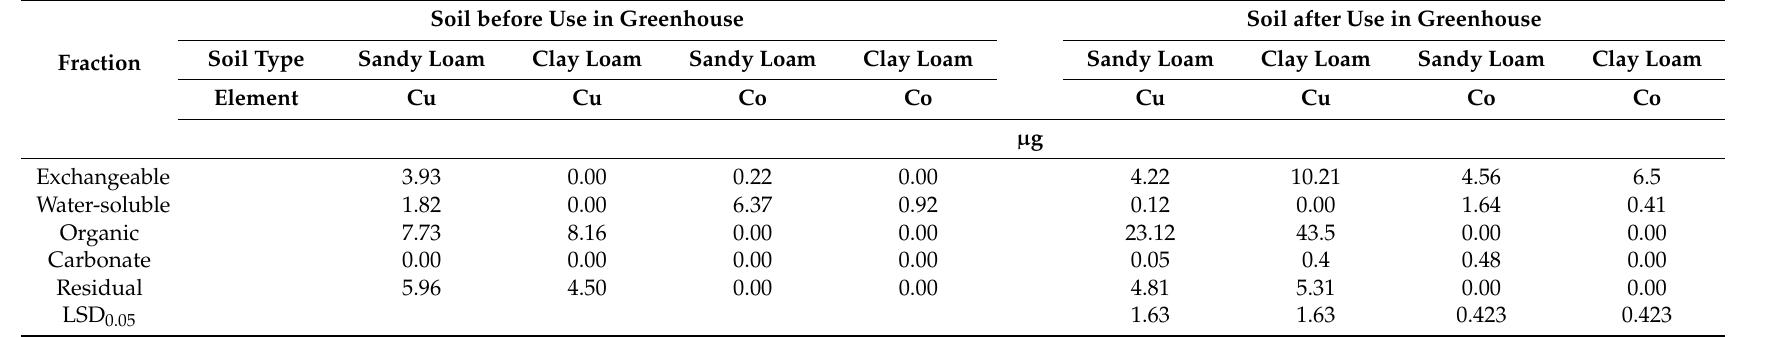
Table 6. Mean amounts of Cu and Co fractions recovered from sandy loam and clay loam soils in a sequential extraction before and after the soils were used in